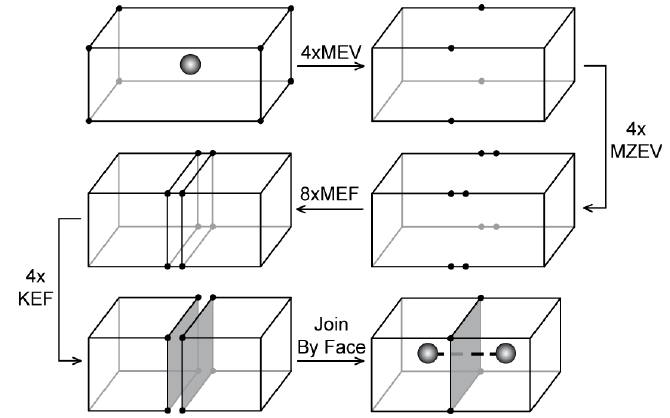
Figure 14. Splitting a box into a complex of two cells.